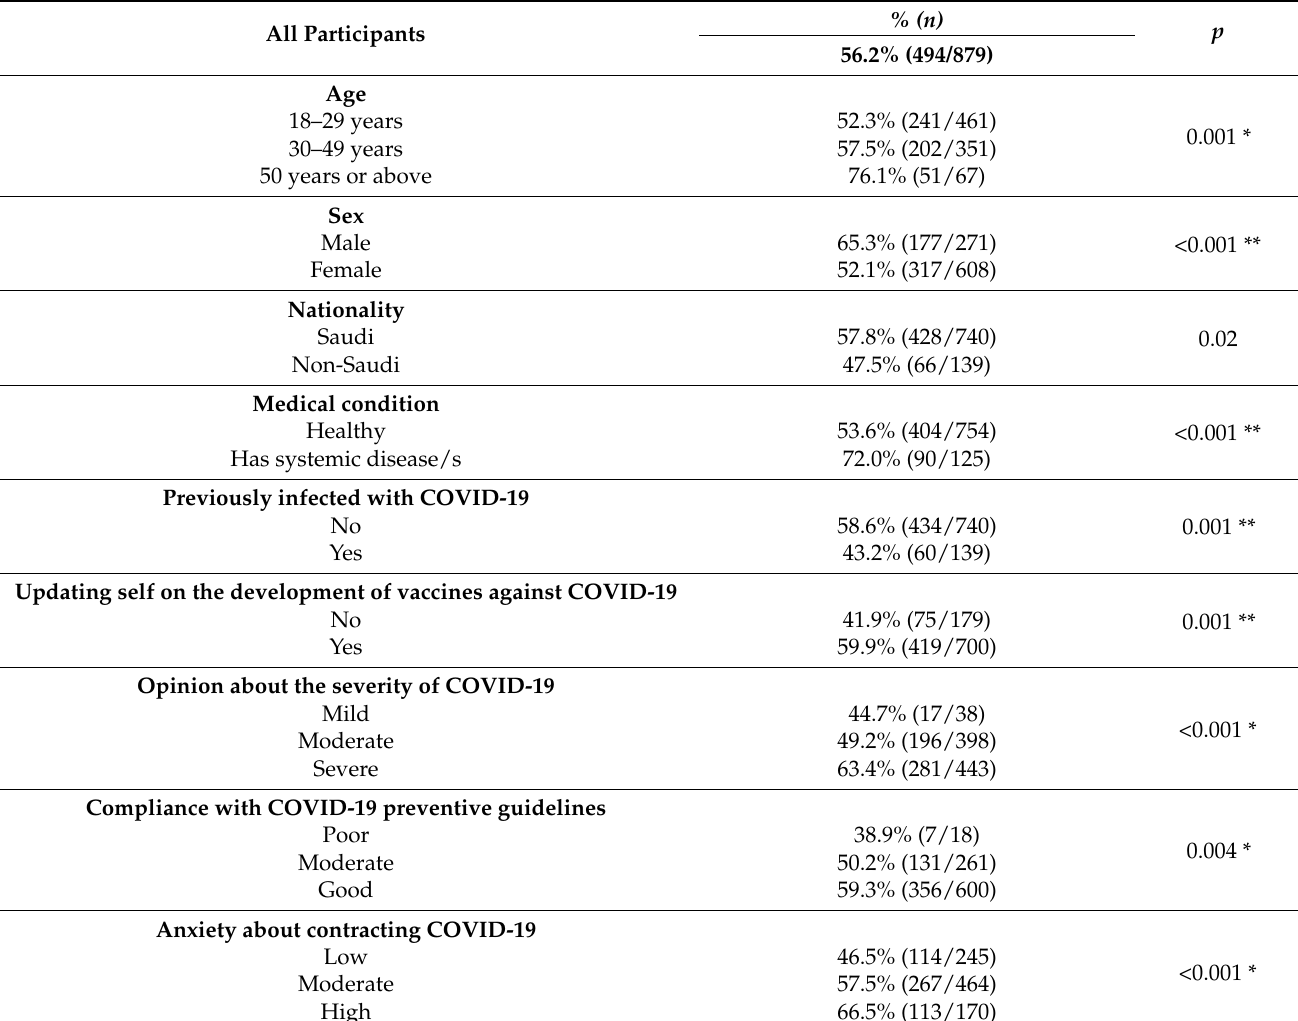
Table 5. Bivariate statistical analysis of relationship between the main outcome “intention to vaccinate” and potential